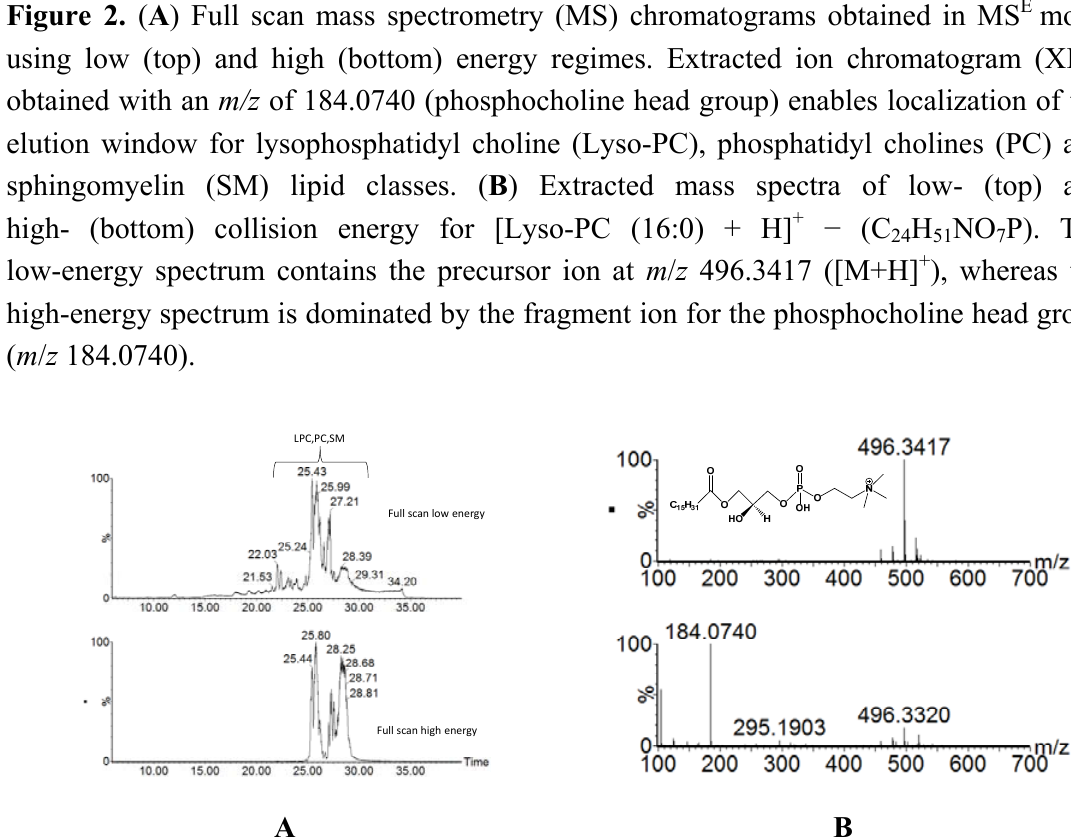
Figure 2. ( A ) Full scan mass spectrometry (MS) chromatograms obtained in MS E mode using low (top) and high (bottom) energy regimes. Extracted ion chromatogram (XIC) obtained with an m/z of 184.0740 (phosphocholine head group) enables localization of the elution window for lysophosphatidyl choline (Lyso-PC), phosphatidyl cholines (PC) and sphingomyelin (SM) lipid classes. ( B ) Extracted mass spectra of low- (top)